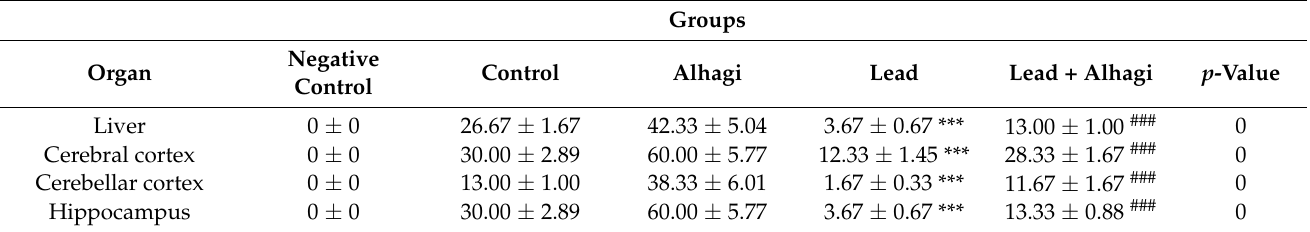
Table 6. Immunohistochemical evaluation of Bcl-2 in the liver and brain tissues of rats in response to lead (100 mg/kg BW, orally) and A. maurorum extract (300 mg/kg BW, orally) treatments daily for 3